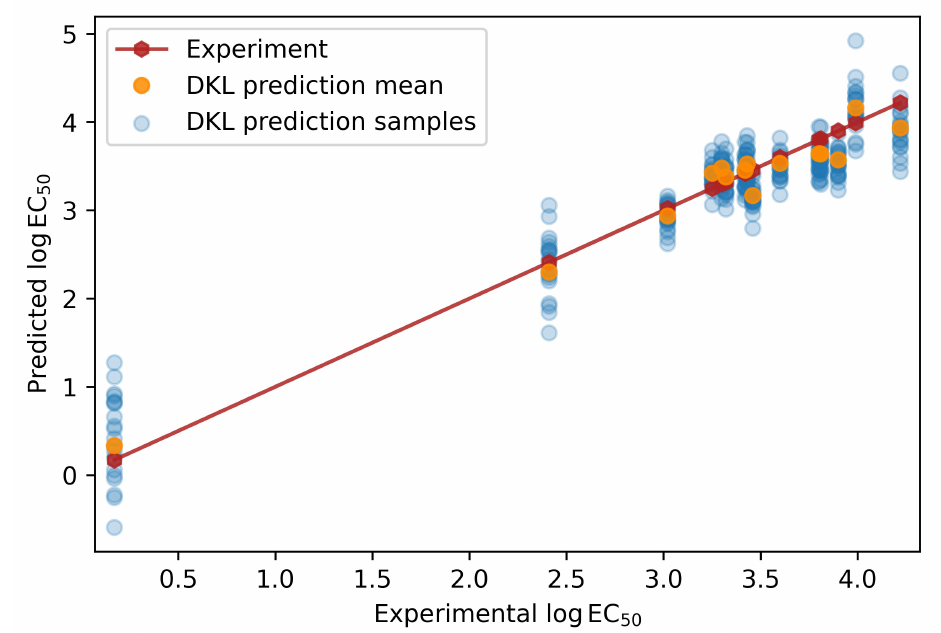
Figure 5. Comparison between experimental and DKL predicted logEC 50 for the fifteen ionic liquids in the test dataset.